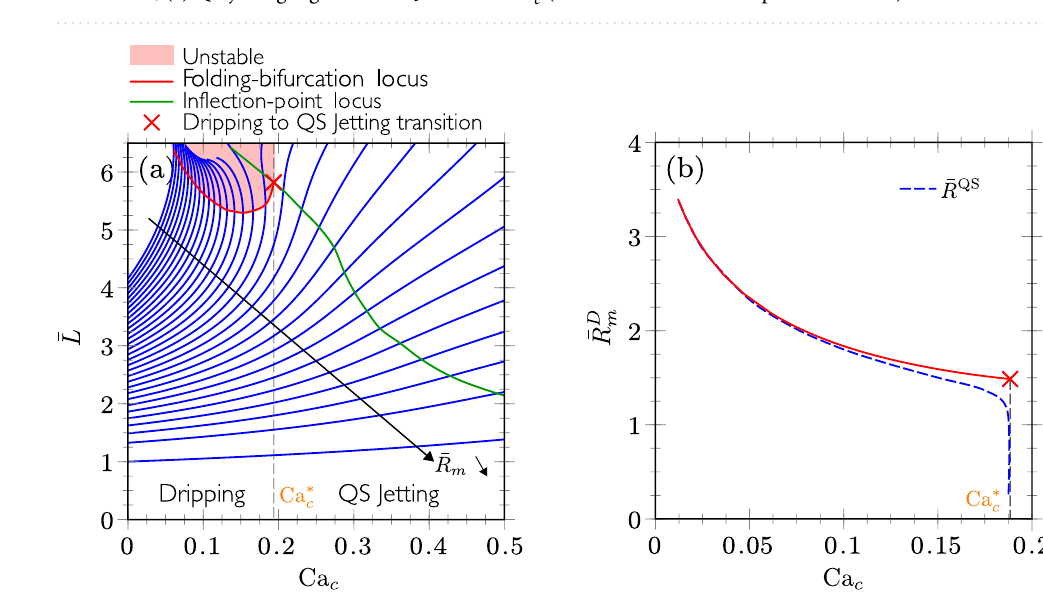
Figure 10. Dripping mode obtained with quasi-static simulations for the geometry of couple 1 and in the inviscid limit (cid:31) = 0 : influence of ( a ) ¯ R m and Ca c on ¯ L and ( b ) Ca c on ¯ R equivalent radius ¯ R QS as defined in Table 2, while the red cross indicates the dripping to jetting transition at Ca ∗ c